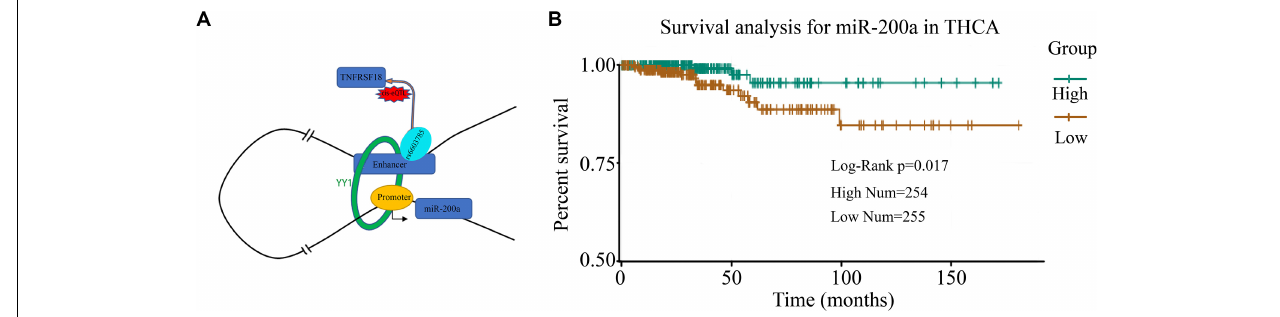
FIGURE 5 | Case study of miRes in thyroid carcinoma. (A) An example of an enhancer–miRNA regulation interaction (chr1:1186391–1186507 ∼ miR-200a). (B) Survival curve of hsa-miR-200a in thyroid cancer.